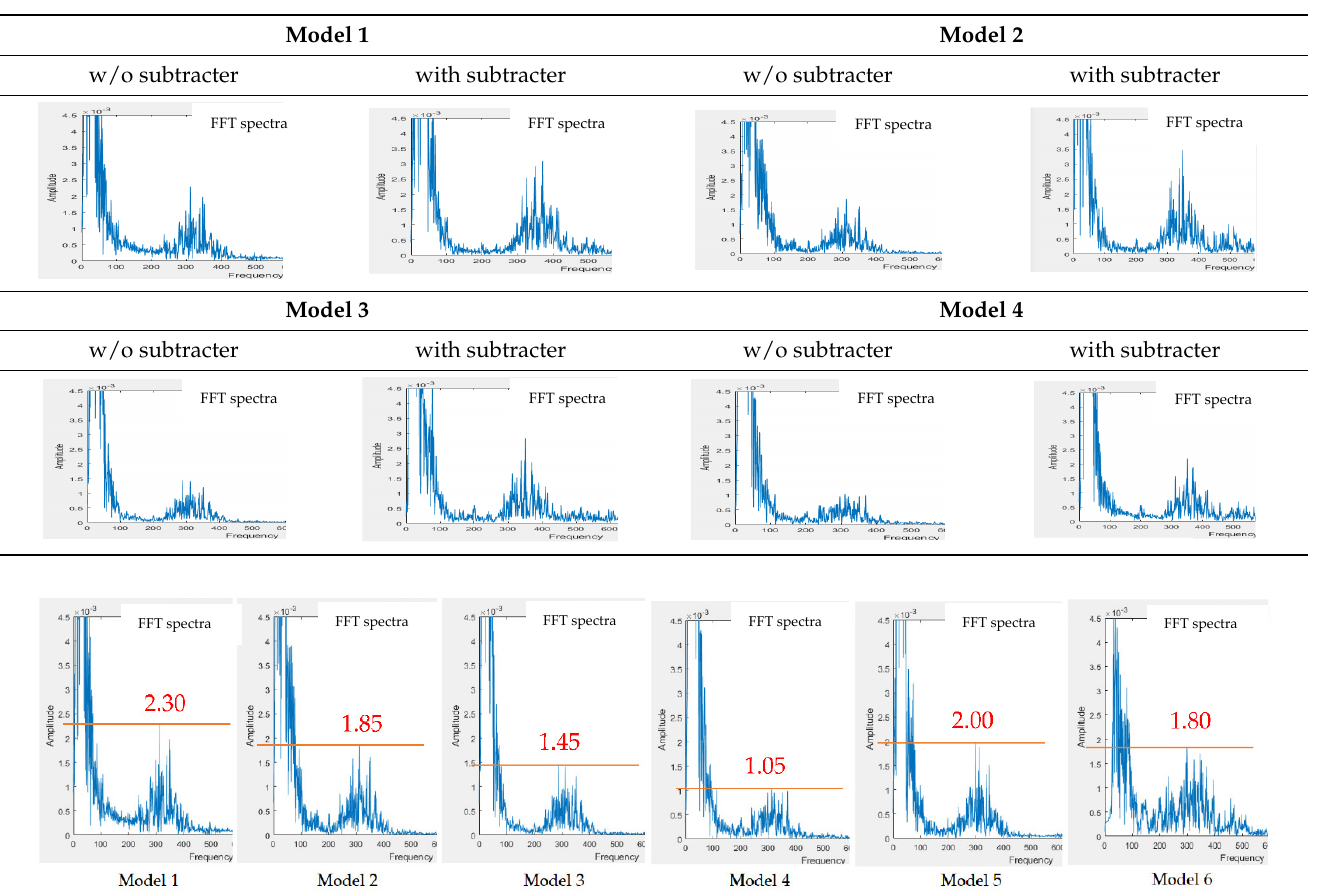
Figure 15. Comparison of FFT spectra of heart sound signals without using the subtracter.